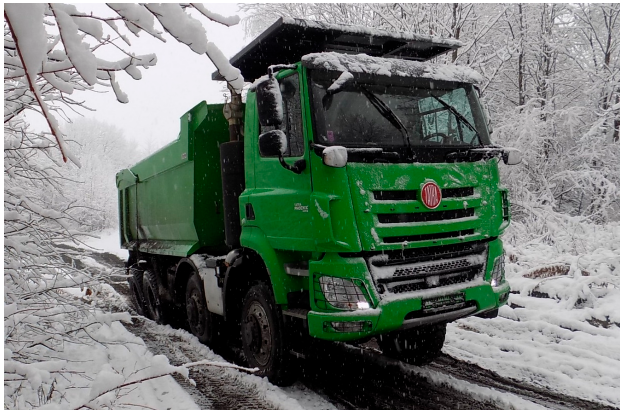
Figure 1. Prototype of a civilian vehicle.